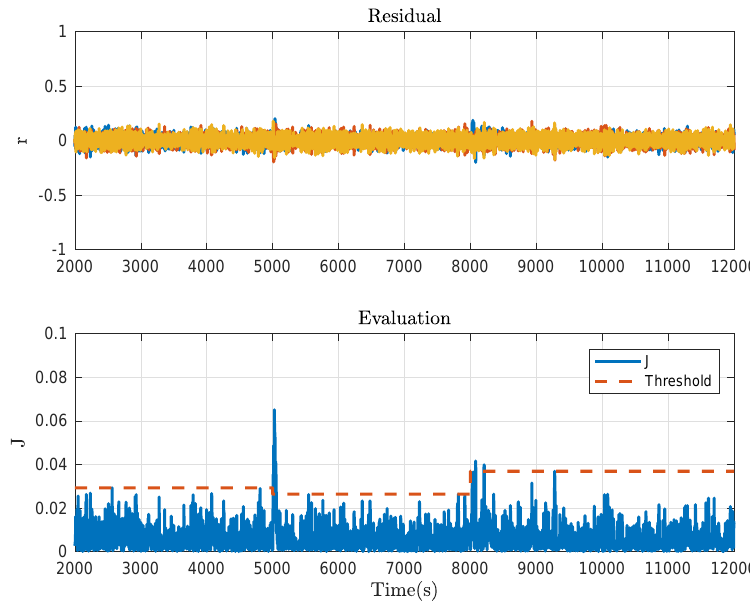
Figure 7. Fault detection result in the fault-free case.